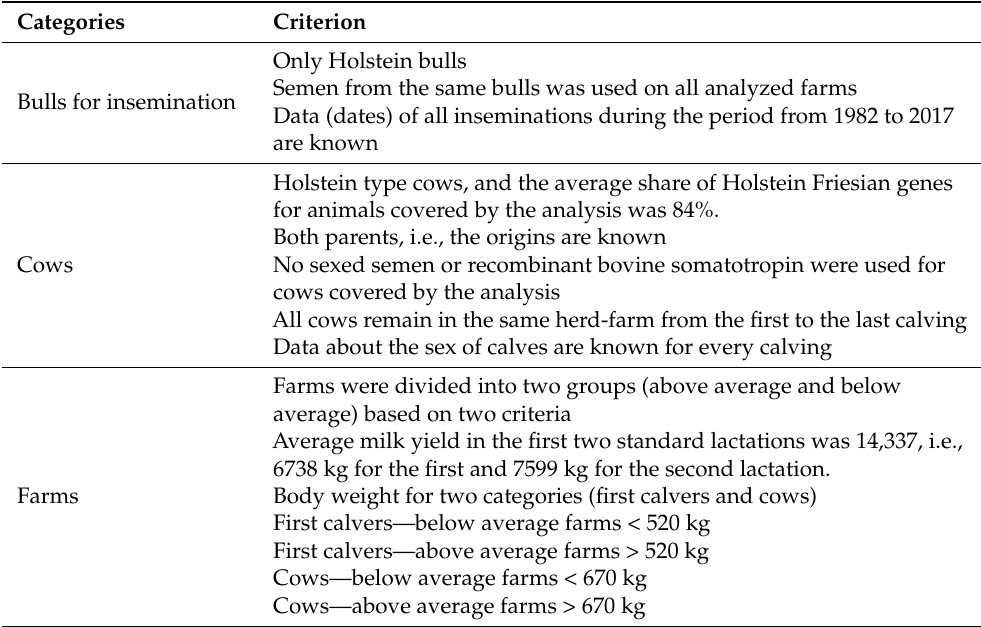
Table 1. Selection criteria for different categories.